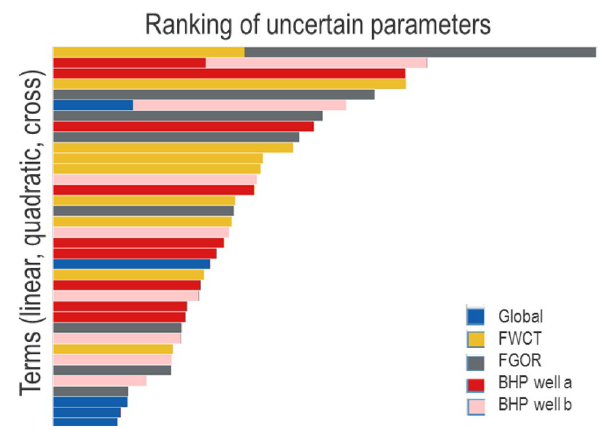
Fig. 10 Top key parameters with high impact on field responses and pressure match. Terms represent linear, quadratic and correlation